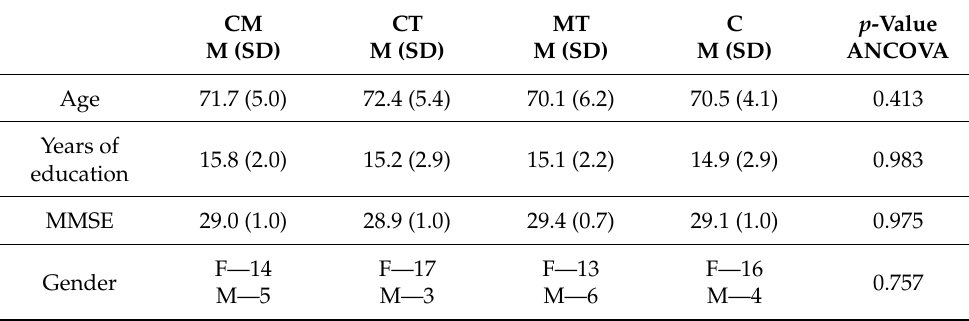
Table 1. Demographic and clinical variables in all